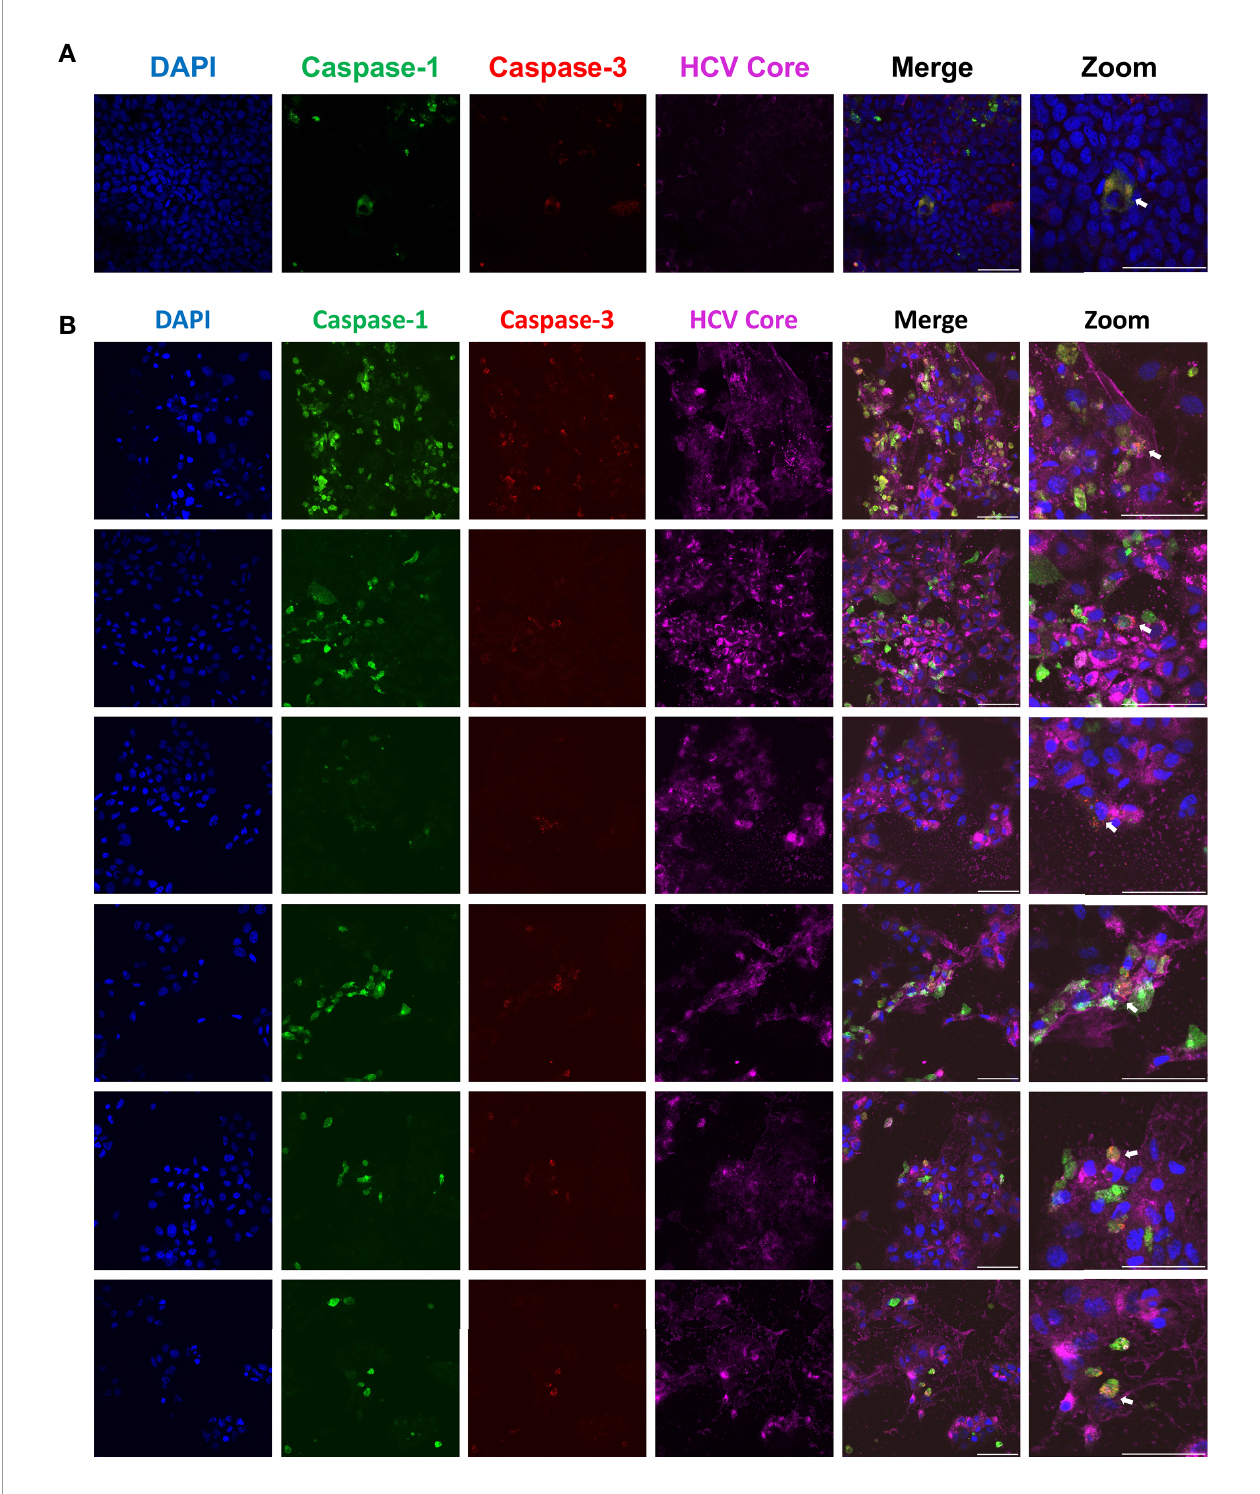
FIGURE 5 | Single cells undergoing apoptosis and pyroptosis simultaneously. Huh-7.5 cells were infected with HCV at MOI = 1. At 3 days p.i., cells were stained for cleaved caspase-1 (green) using a probe and then fi xed using acetone. Cells were subsequently stained using antibodies speci fi c for cleaved caspase-3 (red) and HCV core protein (magenta). Nuclei were stained with DAPI (blue) for analysis by confocal microscopy. (A) The fi rst observed instance of a double positive cell. (B) Subsequent experiments showing additional double positive cells. (A, B) Scale bar, 100 m